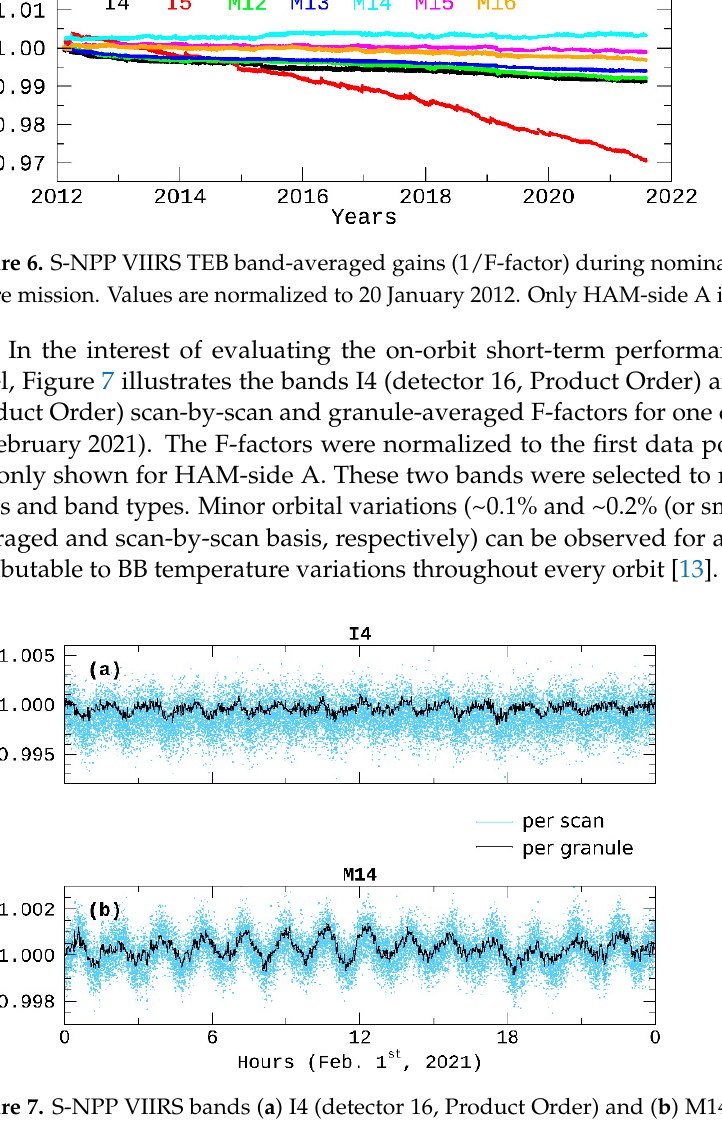
9 of 19 during a short period. These annual gain sequences are correlated to those in the temper- atures used in the instrument thermal calibration model; though, since these temperatures are highly interrelated, it is difficult to pinpoint any specific telemetry temperature. All